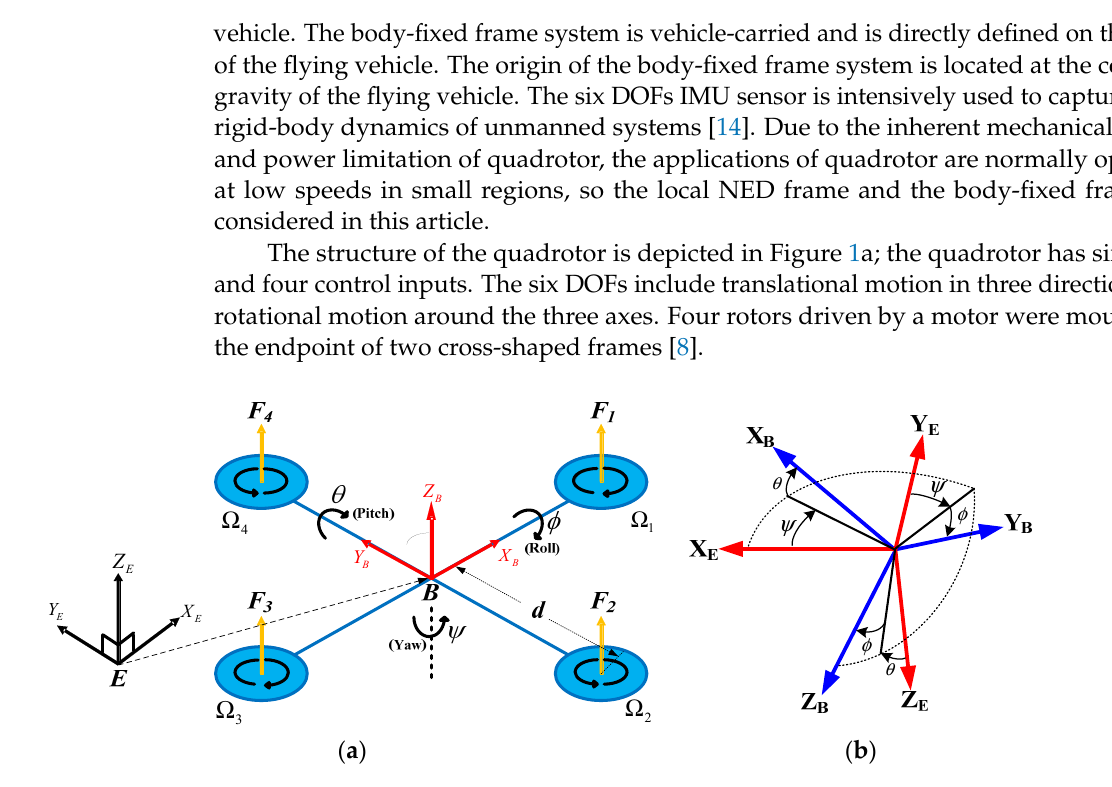
Figure 1. ( a ) Quadrotor configuration frame scheme comprising body-fixed and inertial frames. ( b ) Transfer of Euler angles from body-fixed frame to inertial reference frame.